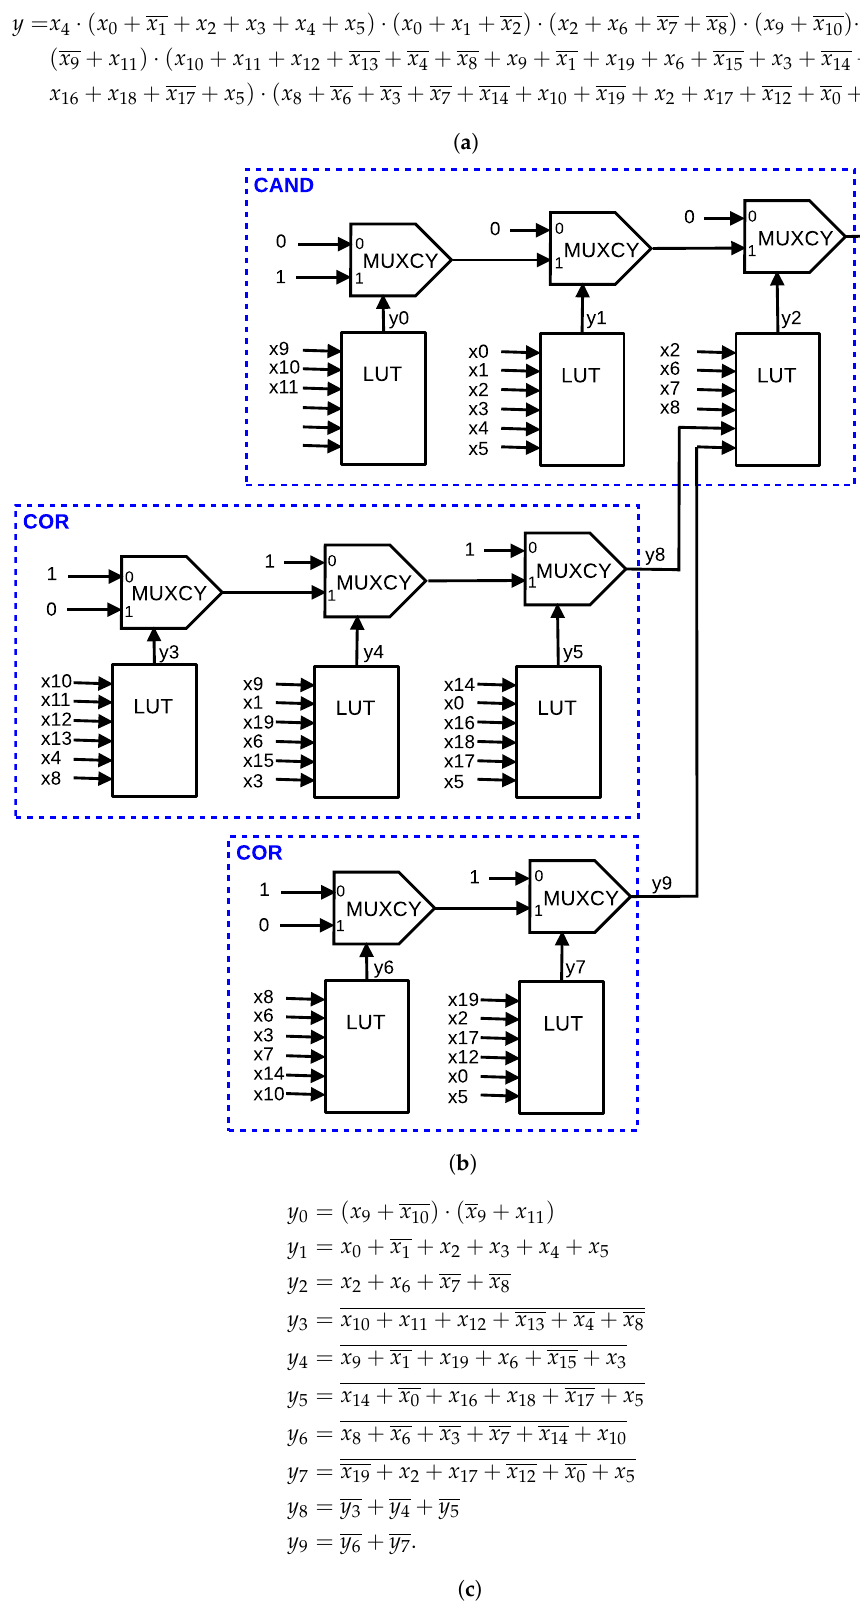
Figure 5. Example of CPOM implementation in a 6-LUT-based FPGA: ( a ) logic function, ( b ) imple- mentation and ( c ) subfunctions implemented by the